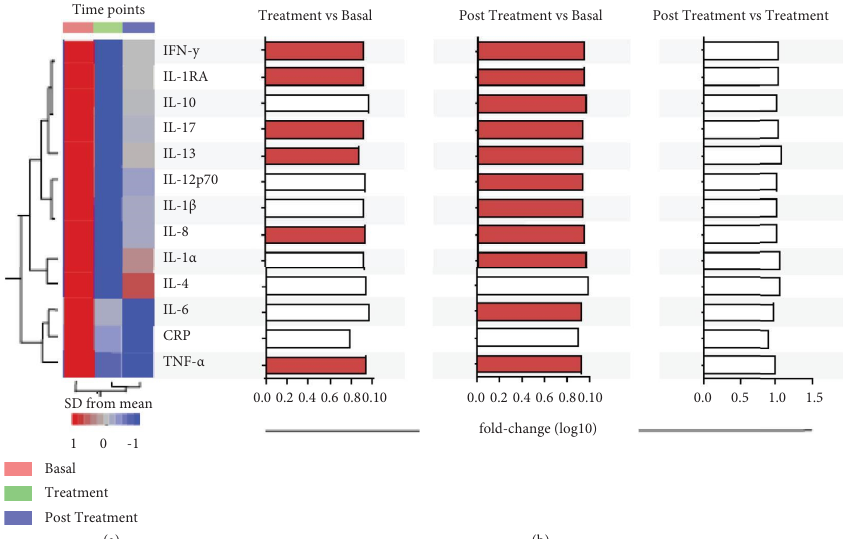
Figure 3: Heatmap demonstrating the infammation profle of patients in the measured periods. Te heatmap (a) shows data for the mean plasma concentration of each indicated marker per time point, and the data were log-transformed and Z score normalized. Tis approach was used to illustrate trends in data variation. A hierarchical cluster analysis (Ward’s method with 100X bootstrap) was used to group the biomarkers with similar distributions between the time points. Dendrograms represent Euclidean distance. Te red and blue colours demonstrate a higher and lower infammatory pattern, respectively. Te fold diferences between the indicated means were calculated, and log10 values were plotted (b). Diferences between each time point were examined using the Wilcoxon matched paired test. Red bars indicate mediators that were signifcantly diferent between the groups.